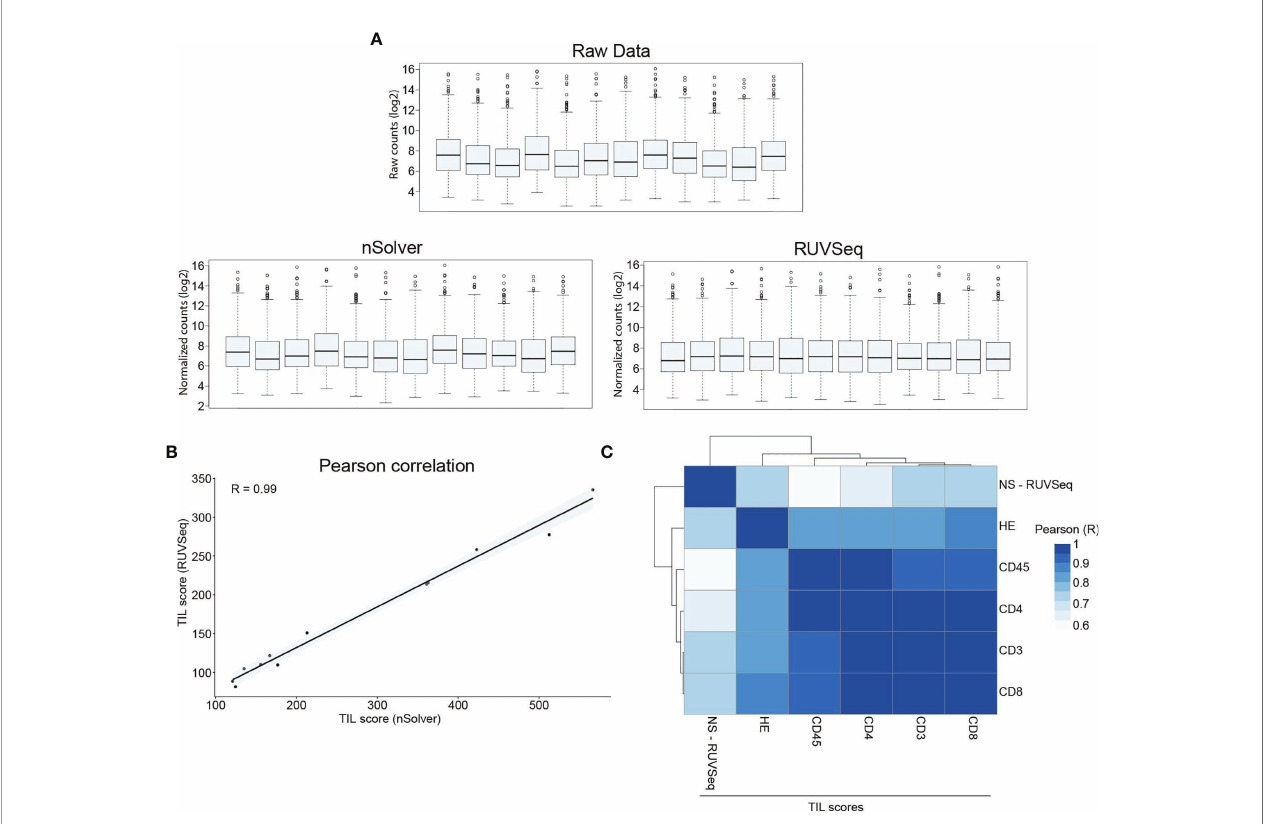
FIGURE 3 | TIL score calculated on RUVSeq-normalized expression data correlates with TIL-score based on immunohistochemistry. (A) Box plots showing raw counts obtained from nCounter MAX analysis, normalized counts using nSolver software, and normalized counts using RUVSeq package. (B) Graph showing the correlation between nSolver- or RUVSeq-calculated TIL scores. (C) Heatmap showing Pearson correlation between different TIL scoring methods. Data information: 12 breast cancer CNB samples were used to extract RNA for downstream gene expression pro fi